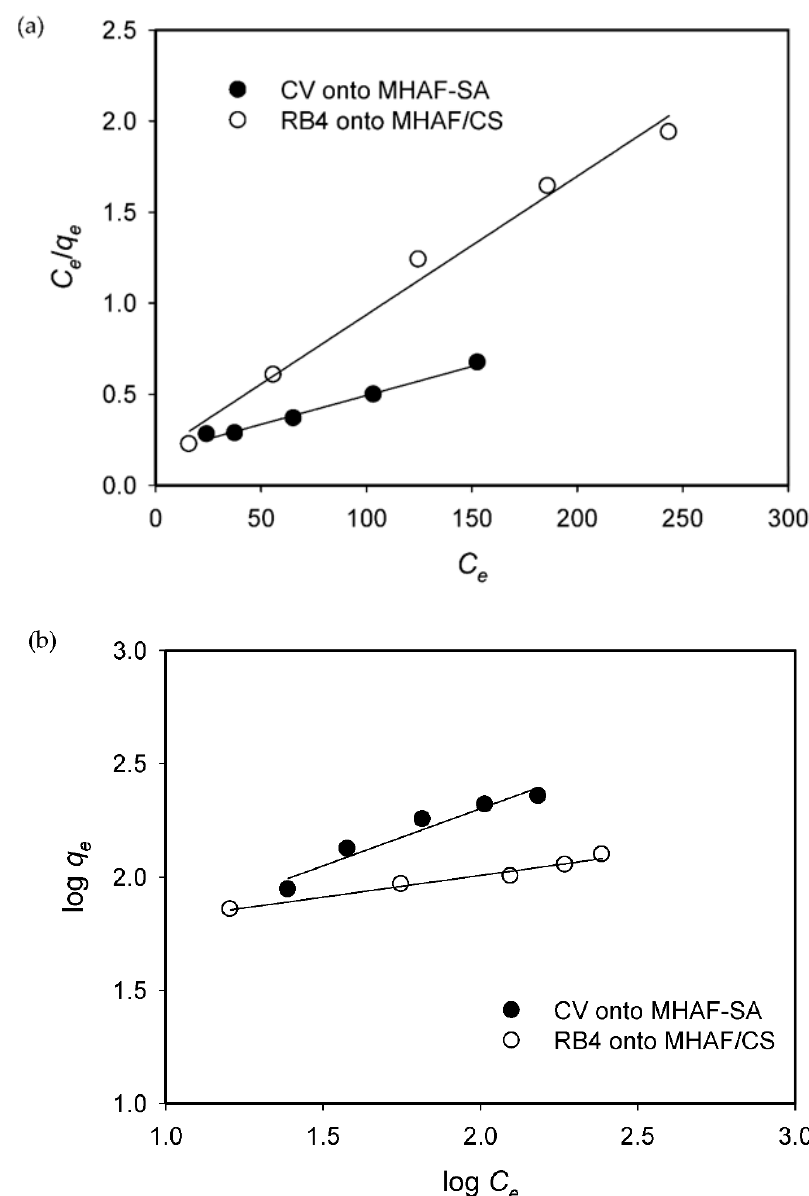
Figure 9. Adsorption isotherm models for dyes adsorption at 40 ◦ C: ( a ) Langmuir, ( b )